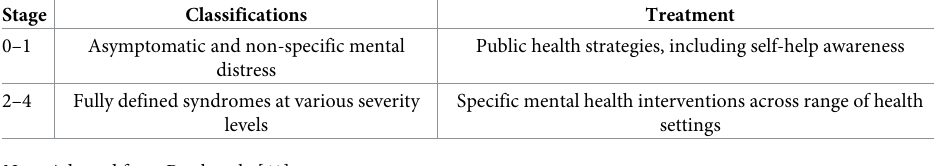
Table 1. Staged approach to classification and treatment of mental health